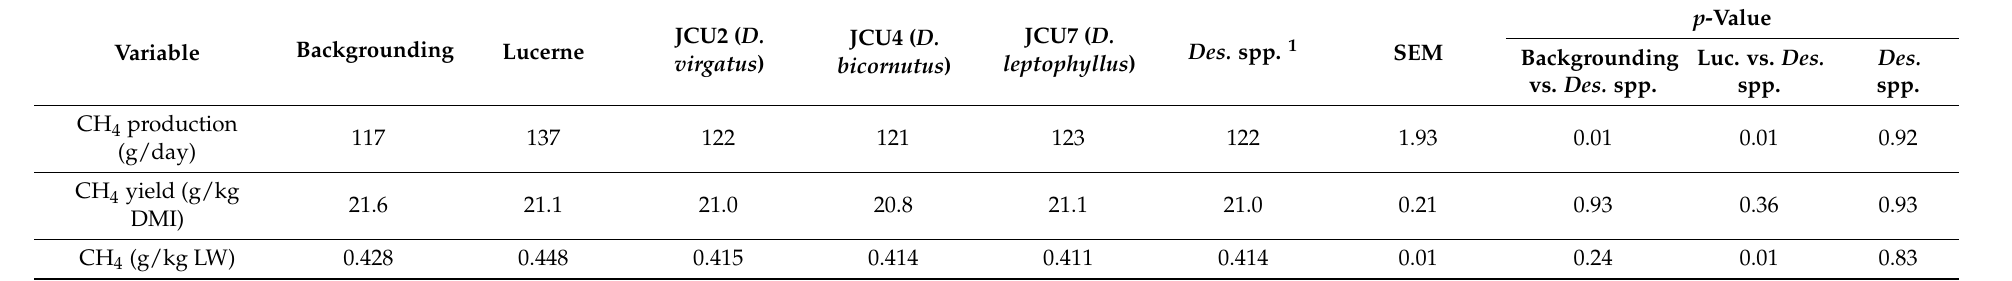
Table 3. Effect of Desmanthus spp. on methane